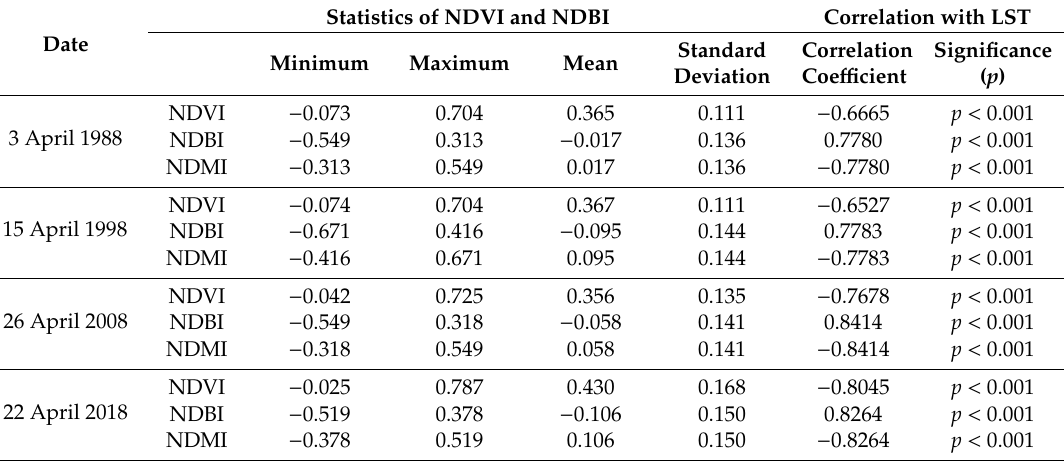
Table 4. Statistics of Land Indices and their correlation with LST.